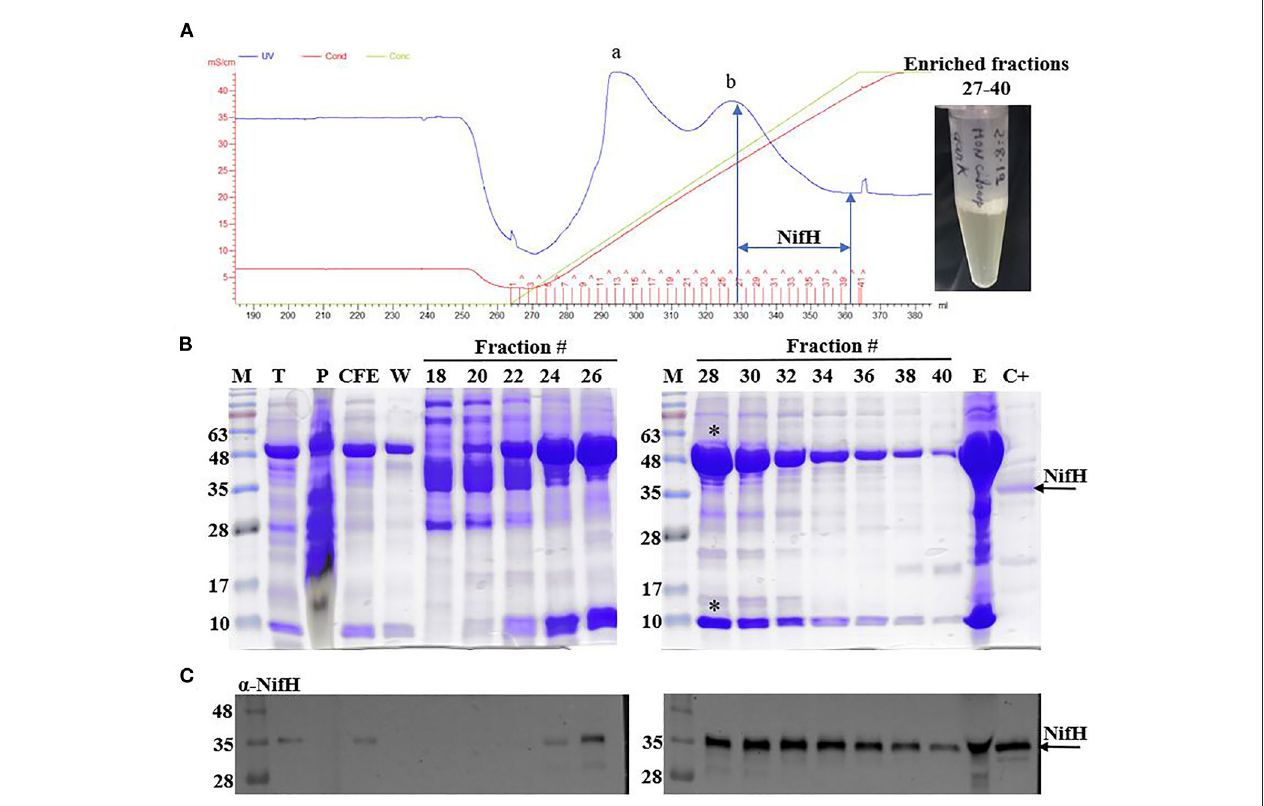
FIGURE 2 | Enrichment of NifH from tobacco leaf extracts. (A) Chromatogram showing a typical procedure for NifH enrichment using Q-Sepharose chromatography. Two main protein elution peaks (a and b) are indicated. Red line, conductivity; blue line, UV-vis absorption; green line, NaCl concentration. Fractions containing NifH (27–40) were pooled and concentrated (final preparation shown to the right). (B, C) Coomassie staining (B) and immunoblots developed with antibodies against NifH ( C ) of SDS gels loaded with selected elution fractions. The large (55 kDa) and small (13 kDa) subunits of Rubisco eluting in peak b are highlighted (*). CFE, soluble protein fraction; C + , pure A. vinelandii NifH; E, pooled NifH-containing fractions 27–40; M, molecular mass markers (kDa); P, membrane fraction (insoluble protein aggregates and proteins associated with membranes); T, total protein extract; W, wash